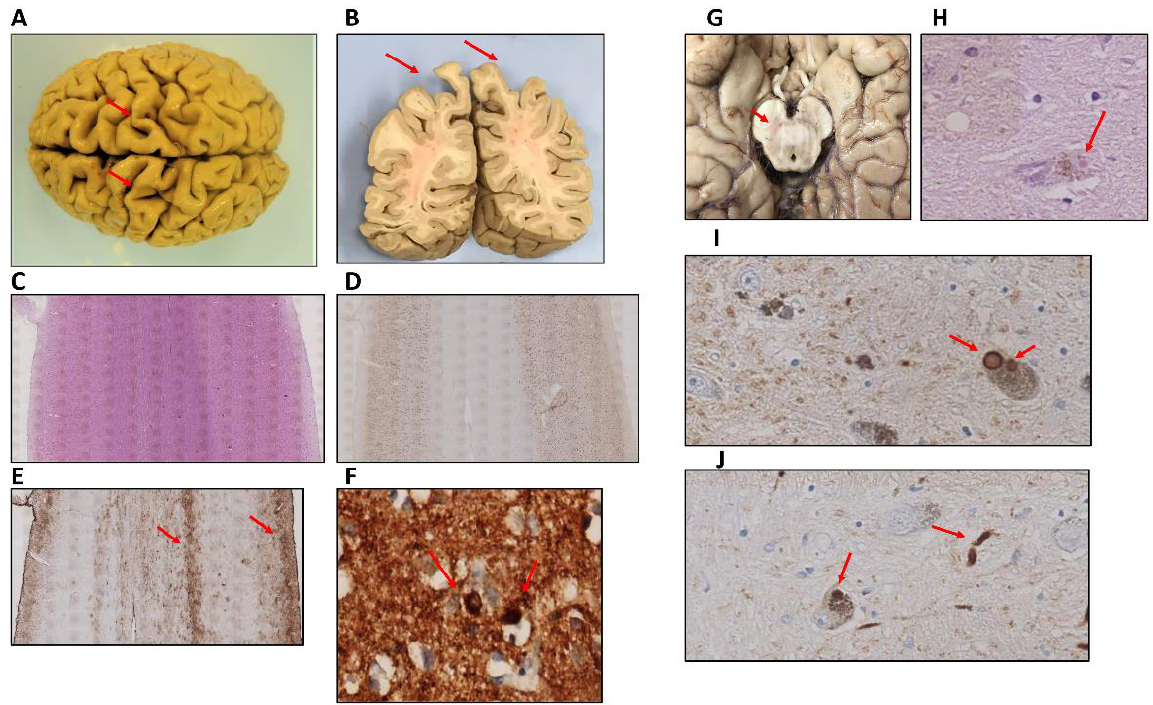
Figure 2. ( A , B ) Sagittal-oriented brain with atrophy at both the dorsal region of the bilateral primary somatosensory cortex ( A ) and the association cortex in the superior parietal lobule ( B ). ( C ) Hema- toxylin-eosin staining of primary somatosensory cortex showing a marked white matter reduction but not evidence of necrotic or inflammatory areas (2×). ( D , E ) Immunohistochemistry for NeuN ( D ) (2×) and GFAP ( E ) (2×) markers revealed no significant neuronal loss but some degree of gliosis in the primary somatosensory cortex. ( F ) Alpha-synuclein aggregates in neurons from IV layer of so- matosensory cortex (40×). ( G – J ) Substantia nigra was less pigmented ( G ) and presented neurons with classical Lewy bodies ( H ) (40×), multiple Lewy bodies ( I ) (40×), and dystrophic neurites ( J ), (40×).